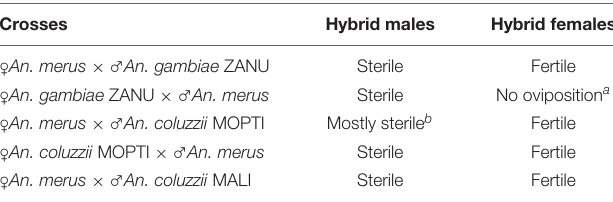
TABLE 1 | Fertility status of F1 inter-species hybrids produced by crossing the laboratory strains. Crosses Hybrid males Hybrid